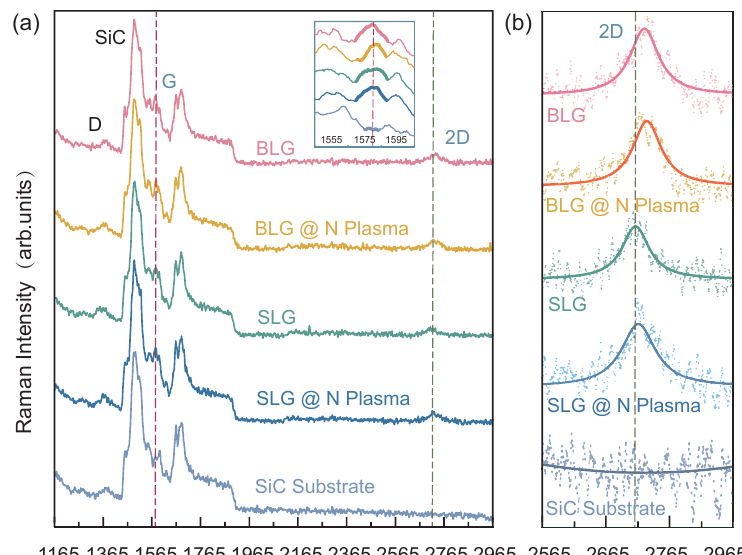
Figure 5. Raman spectra of epitaxial graphene on SiC and SiC substrate. ( a ) Raman spectra of BLG without and with N plasma treatments (denoted as “BLG@N plasma” in the figure), SLG and SLG without and with N plasma (denoted as “SLG@N plasma” in the figure), and Si-face 4H-SiC(0001) substrate. The inset is an enlarge part of the G band region of spectra in panel ( a ). ( b ) High-resolved 2D band of BLG without and with N plasma, SLG without and with N plasma treatments, and Si-face 4H-SiC(0001) substrate, respectively. The dot symbols are experimental data and the solid lines are the fitted curves. There is a shift of ~20 cm − 1 between the 2D band of SLG and